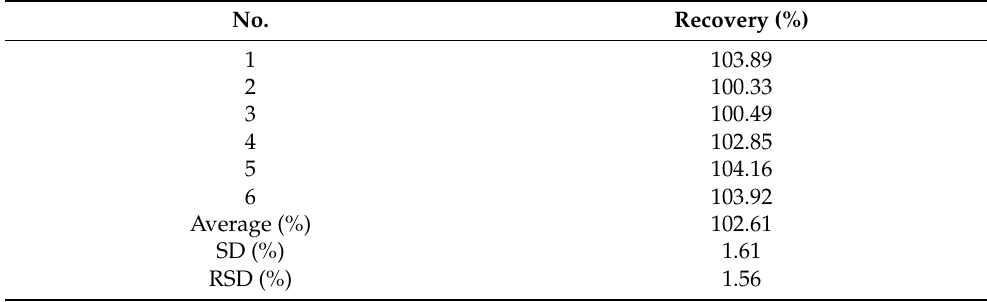
Table 2. Precision data obtained from the developed analysis of MPa. No.